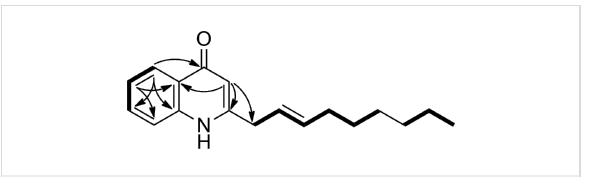
Figure 2: Key COSY (bold line) and HMBC (arrow) correlations for 3 .